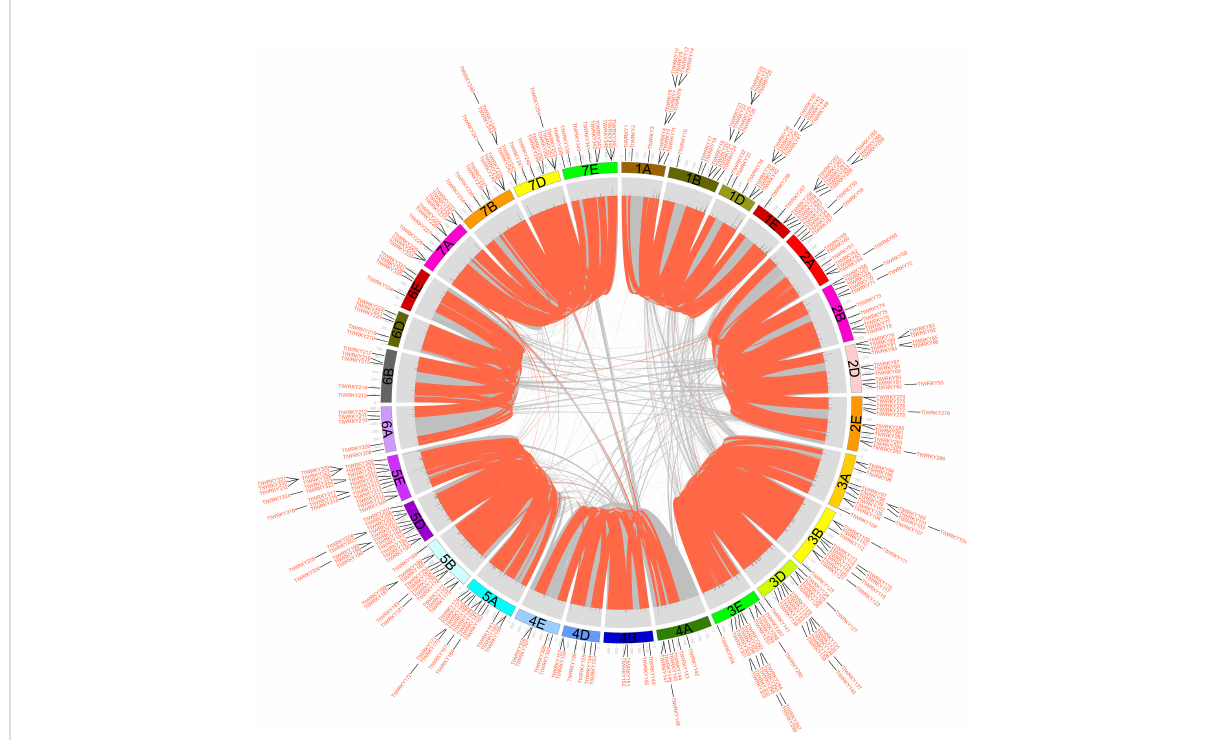
FIGURE 3 distribution, duplication and synteny analysis of WRKY genes in Tritipyrum. Collinear correlations of WRKY in Tritipyrum genomes are displayed by Circos. Tritipyrum chromosomes are colored according to the inferred ancestral chromosomes following an established convention. In the center, the relative map position of 345 WRKY genes is shown on each of the 28 Tritipyrum